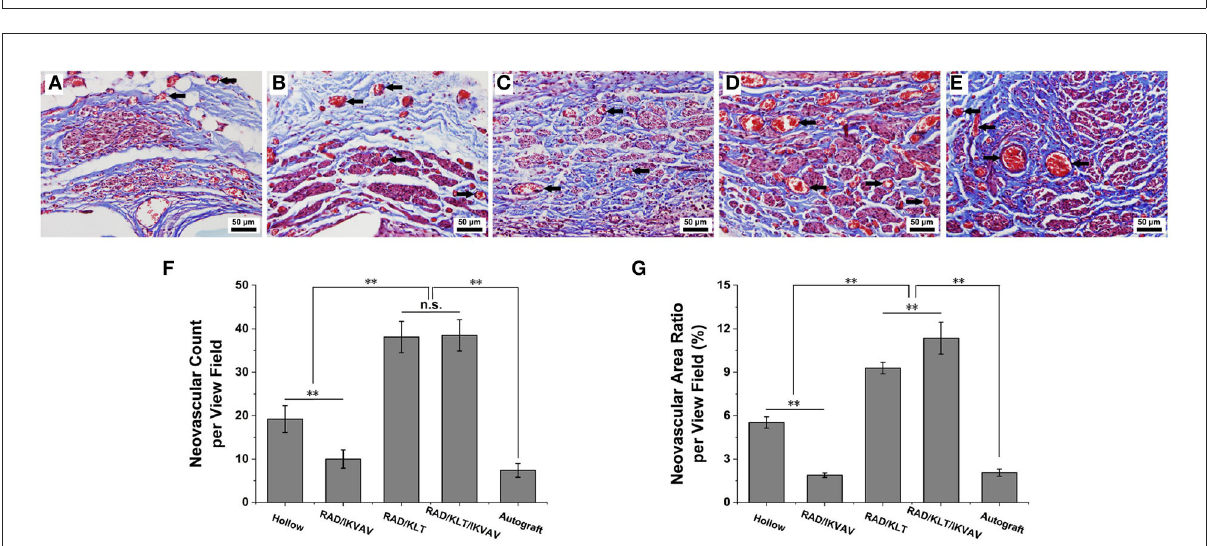
FIGURE4 Histological analysis of angiogenesis in the middle segments of the implanted grafts at 6 weeks after surgery and the neovascular of the implanted grafts are indicated by black arrows. (A–E) Representative transverse images of Masson’s trichrome staining from (A) Hollow group (B) RAD/IKVAV group (C) RAD/KLT group (D) RAD/KLT/IKVAV group, and (E) Autograft group. (F) The neovascular count per view field in each group. (G) The neovascular area ratio per view field in each group. Data are expressed as means ± SEM. * p < 0.05, ** p < 0.01, n.s. represents